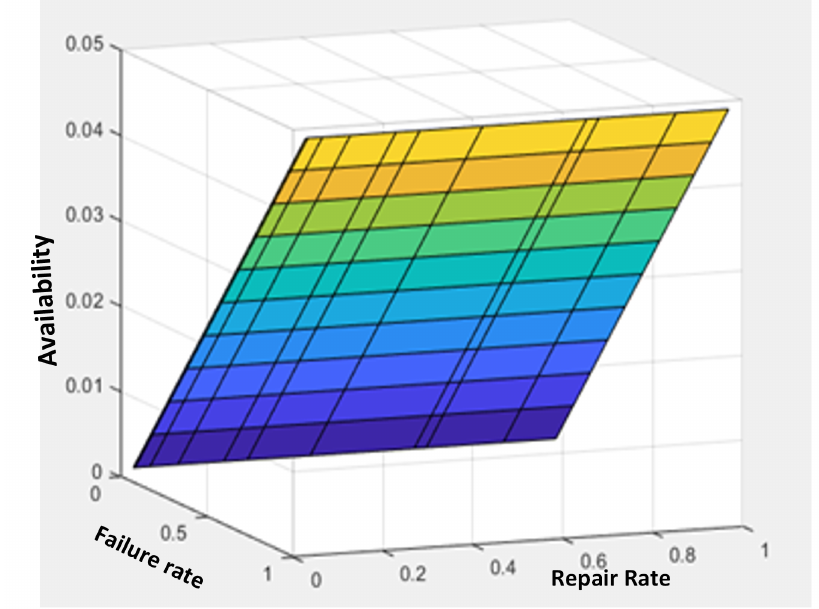
Figure 6. Availability concerning failure rate and repair rate.